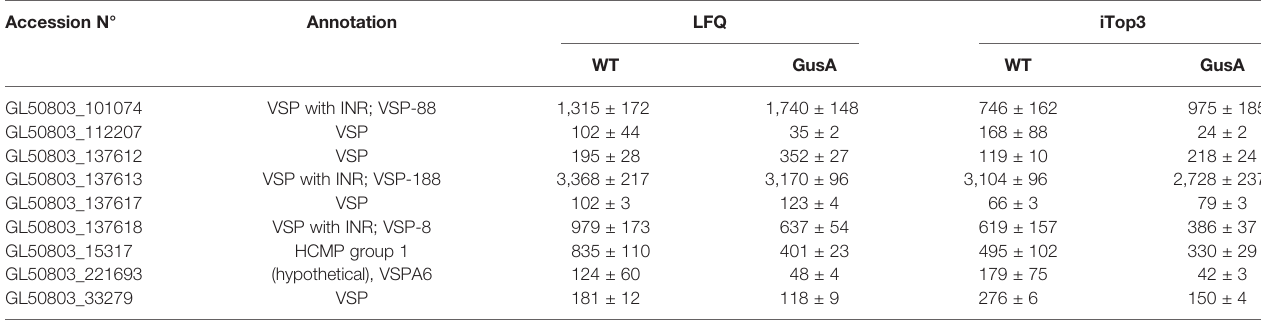
TABLE 3 | Major surface antigens without signi fi cant differences in expression levels between untransfected G. lamblia WBC6 wildtype (WT) and E. coli glucuronidase A (GusA)-transfected trophozoites. Accession